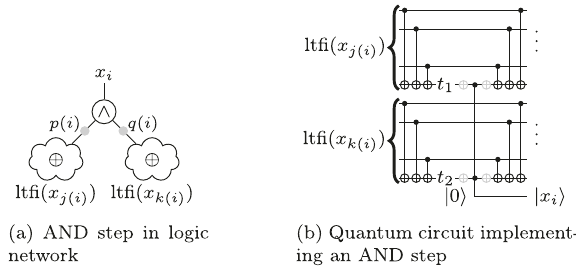
Fig. 4 Illustration of the general idea in which the fan-in nodes of an AND gate are considered as large XOR gates, computed in- place using CNOT gates. a An AND step in an XAG network; b corresponding compiled quantum